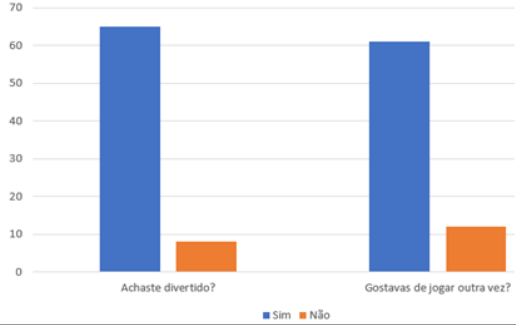
Figure 7. Students’ answers to the questions: Did you have fun playing the game? Would you like to play it again?